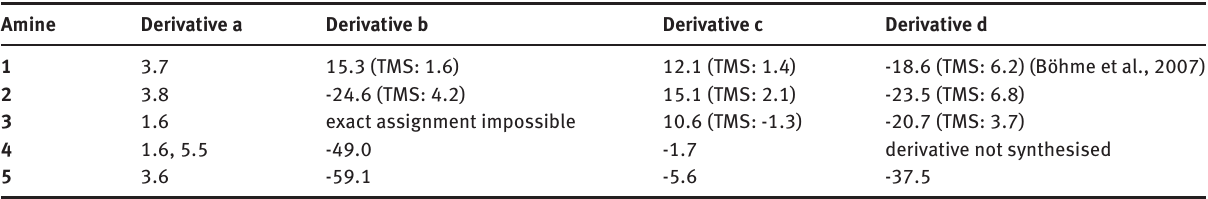
TMS: Trimethylsilyl